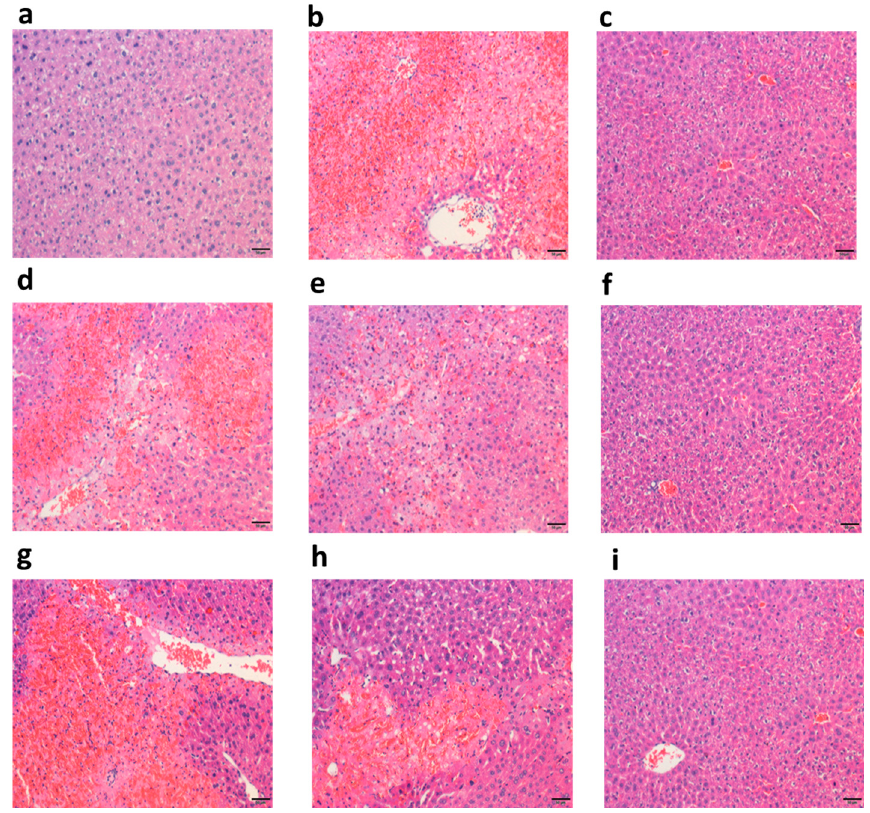
Figure 5. Effects of DRP1 and DRP2 on histopathological changes in liver tissues (magnification 200×). ( a ) liver of mice in the NC group; ( b ) liver of mice in the model control (MC) group; ( c ) liver of mice in the positive control (PC) group; ( d – f ) liver of mice injected with DRP1 at dosage of 50, 100 and 200 mg/kg; and ( g – h ) liver of mice injected with DRP2 at dosage of 50, 100 and 200 mg/kg, respectively.